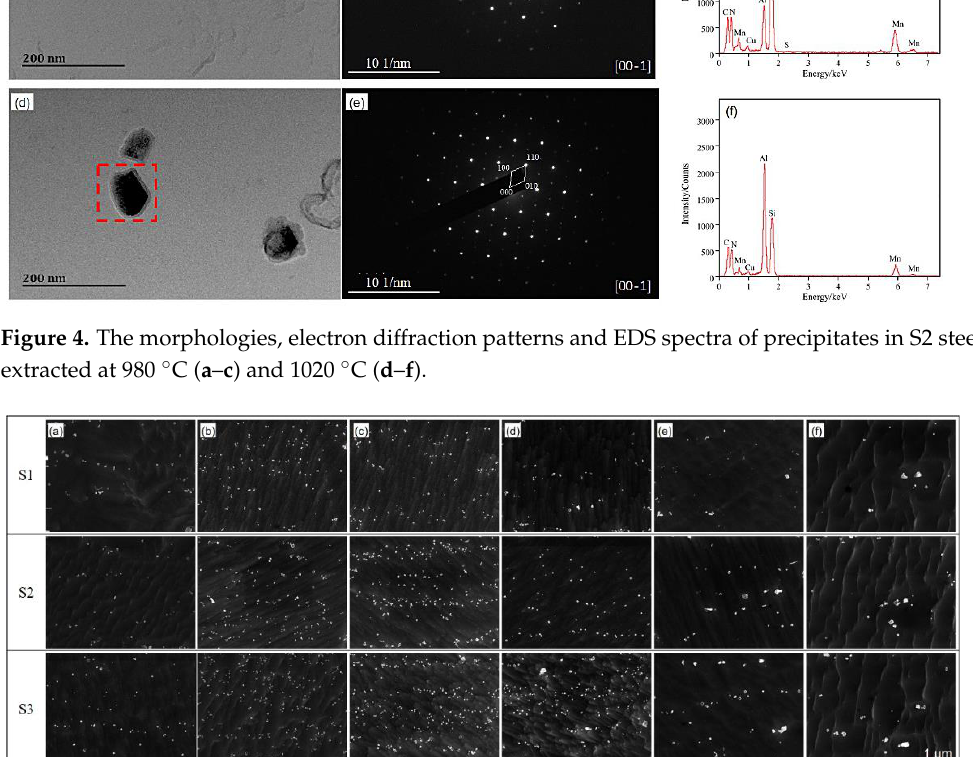
Figure 4. The morphologies, electron diffraction patterns and EDS spectra of precipitates in S2 steel extracted at 980 °C ( a – c ) and 1020 °C ( d – f ).